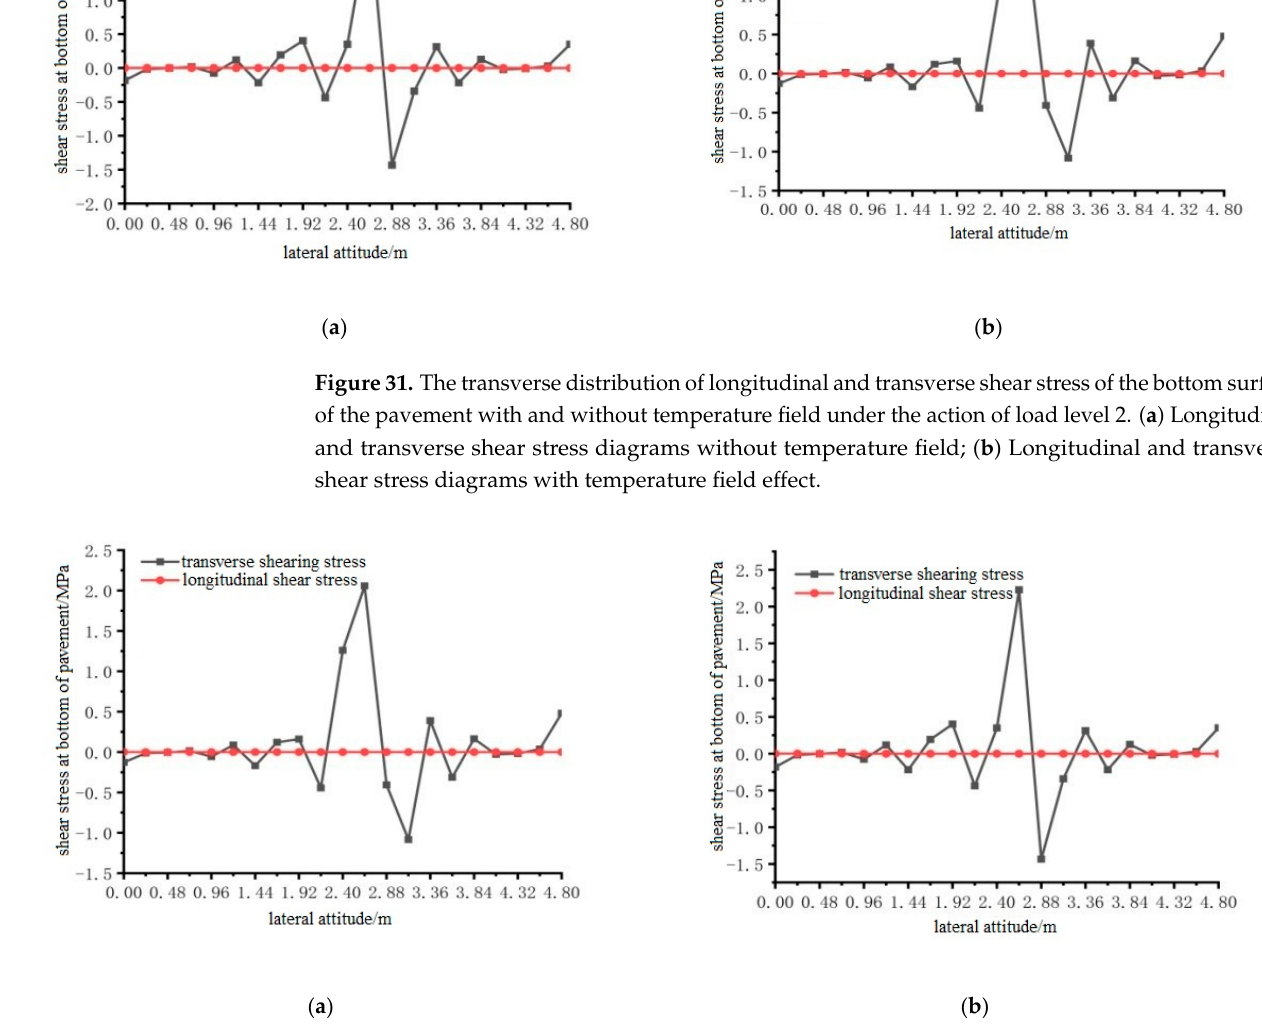
Figure 32. The transverse distribution of longitudinal and transverse shear stress on the bottom surface of the pavement with and without temperature field under the action of load level 3. ( a ) Longitudinal and transverse shear stress diagrams without temperature field; ( b ) Longitudinal and transverse shear stress diagrams with temperature field effect.